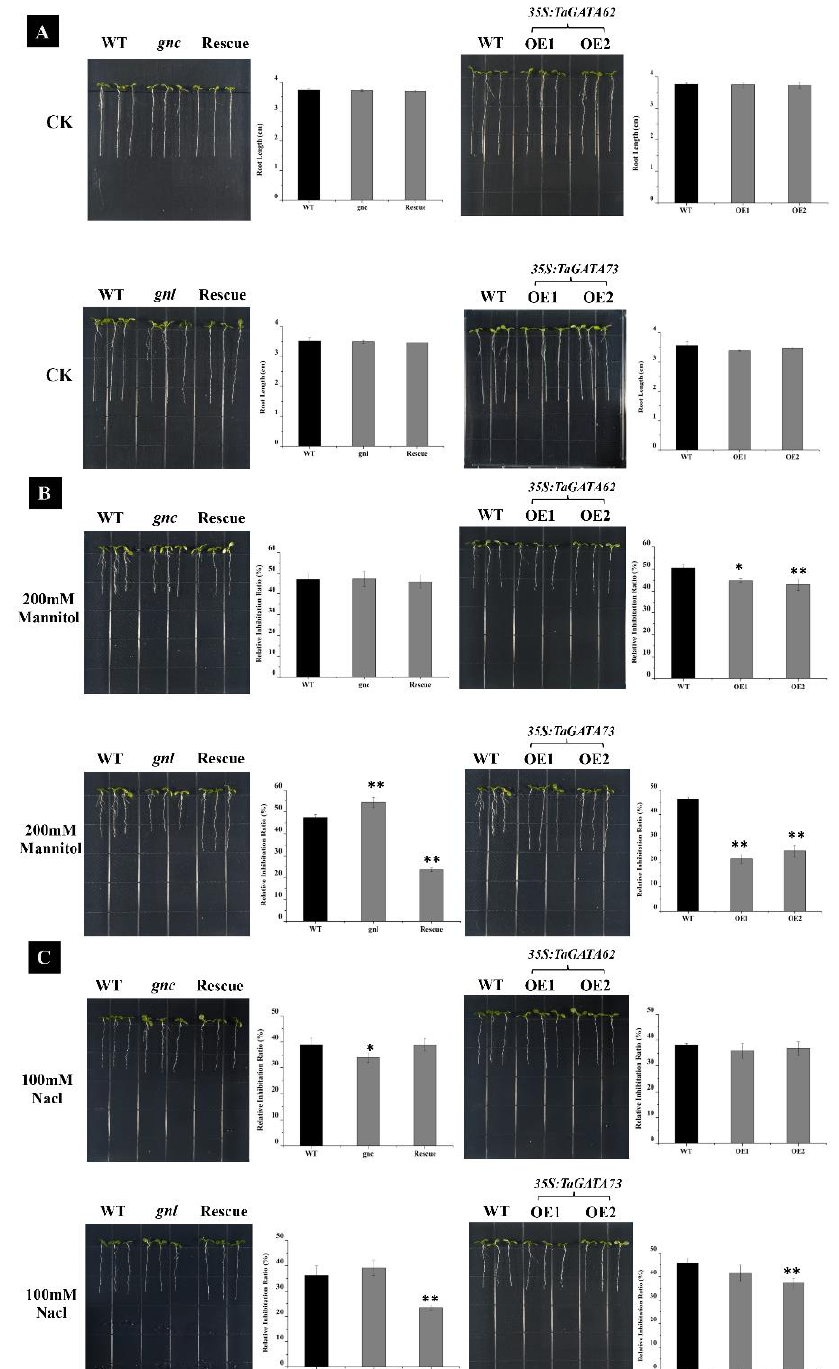
Figure 9. Effects of 200 mM mannitol and 100 mM NaCl treatments on the root growth of TaGATA62 and TaGATA73 transgenic Arabidopsis plants. ( A ) Phenotype of 35s:TaGATA62 and 35s:TaGATA73 transgenic plants under normal conditions. ( B ) Phenotype of 35s:TaGATA62 and 35s:TaGATA73 transgenic plants under 200 mM mannitol treatment. ( C ) Phenotype of 35s:TaGATA62 and 35s:TaGATA73 transgenic plants under 100 mM NaCl treatment. Mean ± SD of data from three independent biological replicates. gnc , the loss-of-function mutant of TaGATA62; gnl , the loss-of-function mutant of TaGATA73; OE, the overexpression lines of TaGATA62 and TaGATA73. * p < 0.05; ** p < 0.01.